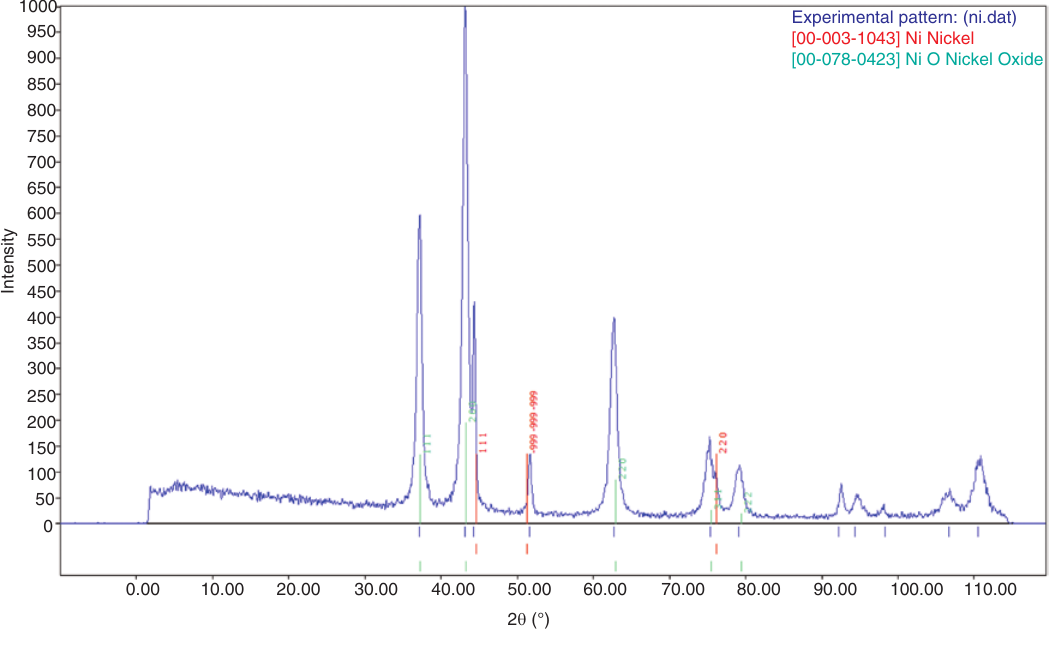
Figure 4: XRD pattern of synthesized nickel oxide.